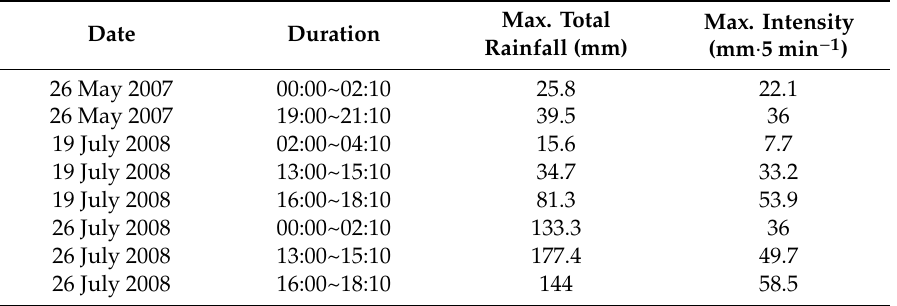
Table 5. Precipitation statics of selected events with 5 min accumulated data from the Essen radar. The static parameters are Max. Total Rainfall, Max.